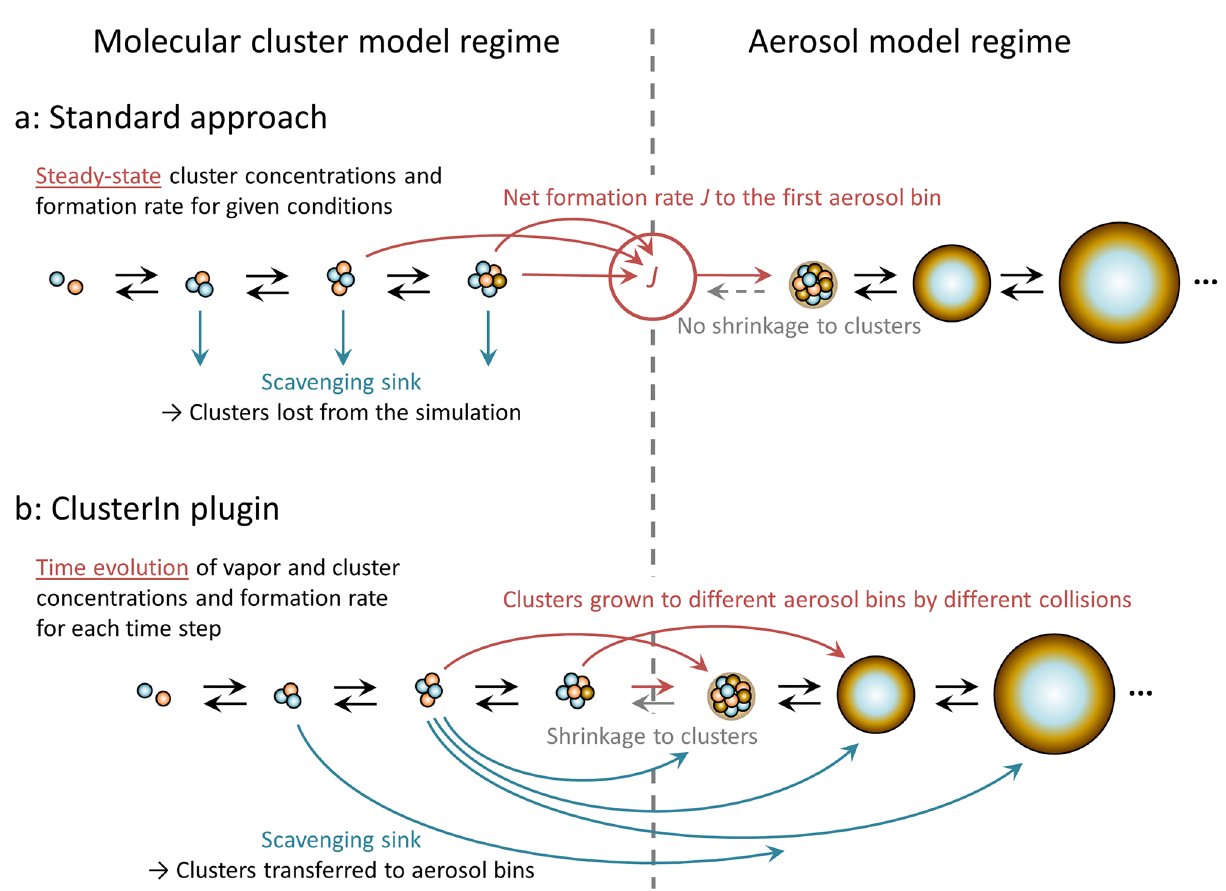
Figure 1. A schematic presentation of the treatment of gas–cluster–aerosol dynamics processes assuming the standard simplifications, and within an explicit framework. ( a) The standard aerosol dynamics model set-up. ( b) The present explicit approach, based on coupling a molecular cluster extension to an aerosol dynamics